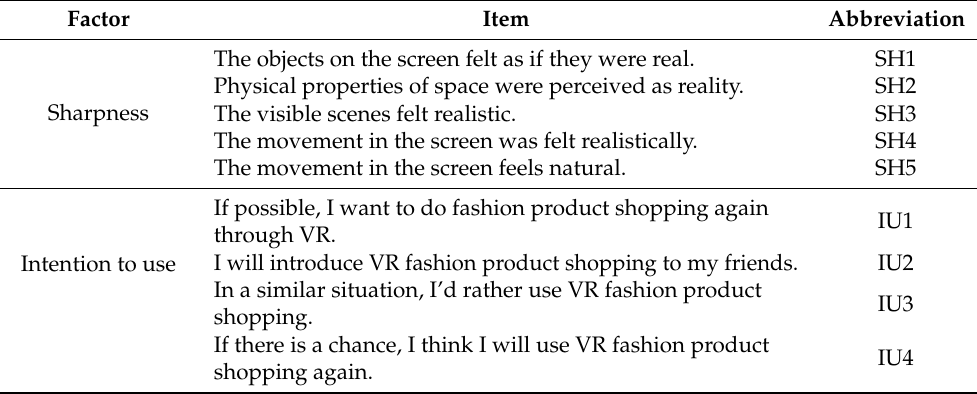
Table 2. Cont. Factor Item Abbreviation